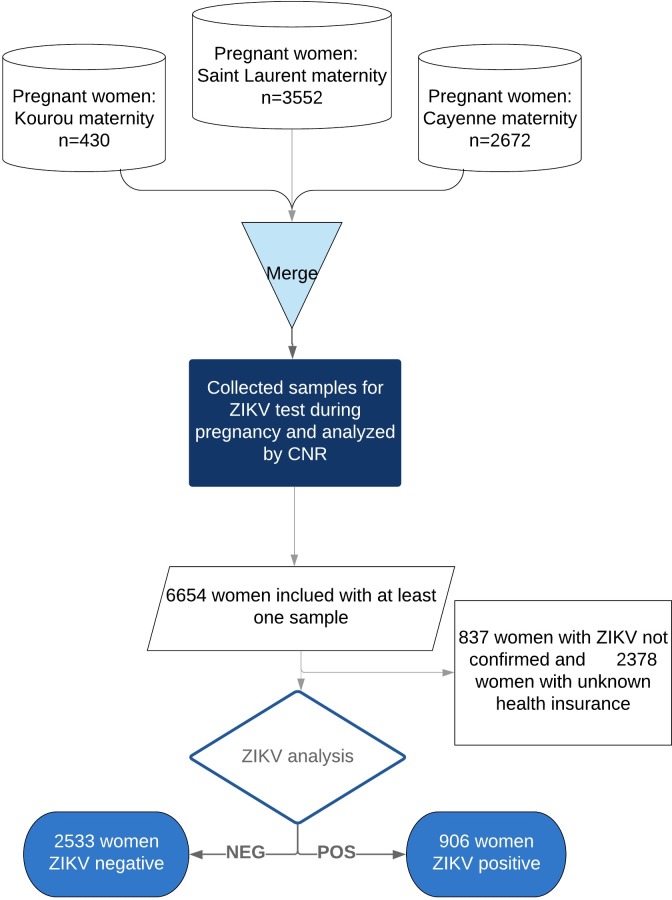
Study flowchart.Origin of patients and sample selection.